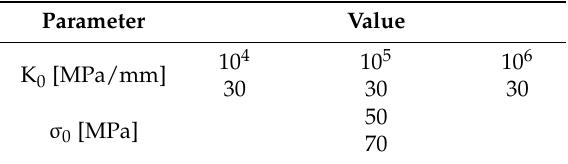
Table 2. CZM parameters that are varied in the